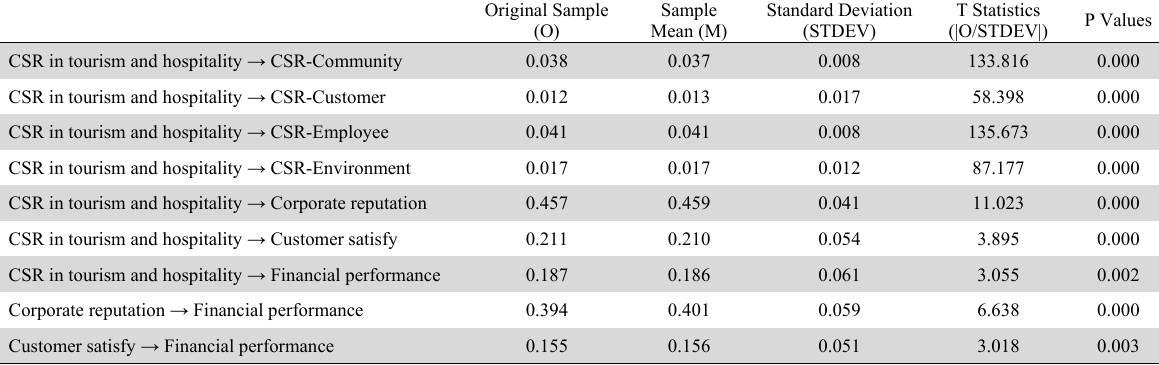
Path Coefficients (Mean, STDEV, T-Values, P-Values)